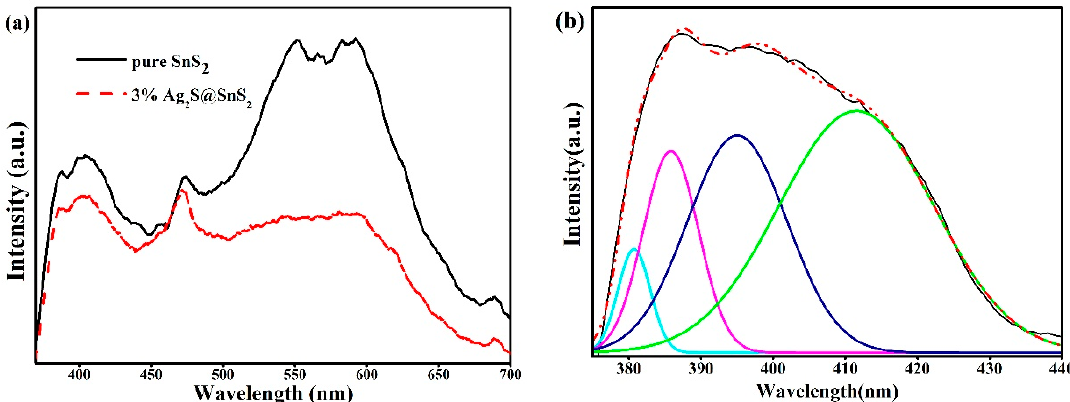
Figure 5. The photoluminescence spectrum of pure SnS 2 and 3% Ag 2 S@SnS 2 composite ( a ), Locally fitted spectrum of pure SnS 2 nanoflowers ( b